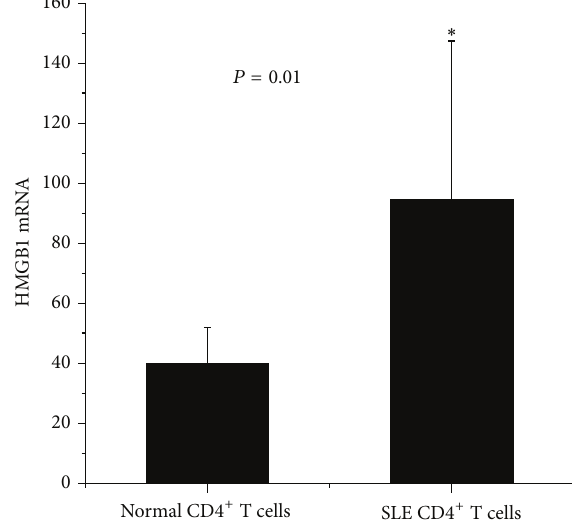
Figure 2: Real-time PCR quantification of HMGB1 mRNA in CD4 + T cells. HMGB1 mRNA in CD4 + T cells isolated from patients with SLE and healthy controls was determined by quantita- tive real-time PCR. Results are normalized to 𝛽 -actin and presented as mean + SD.